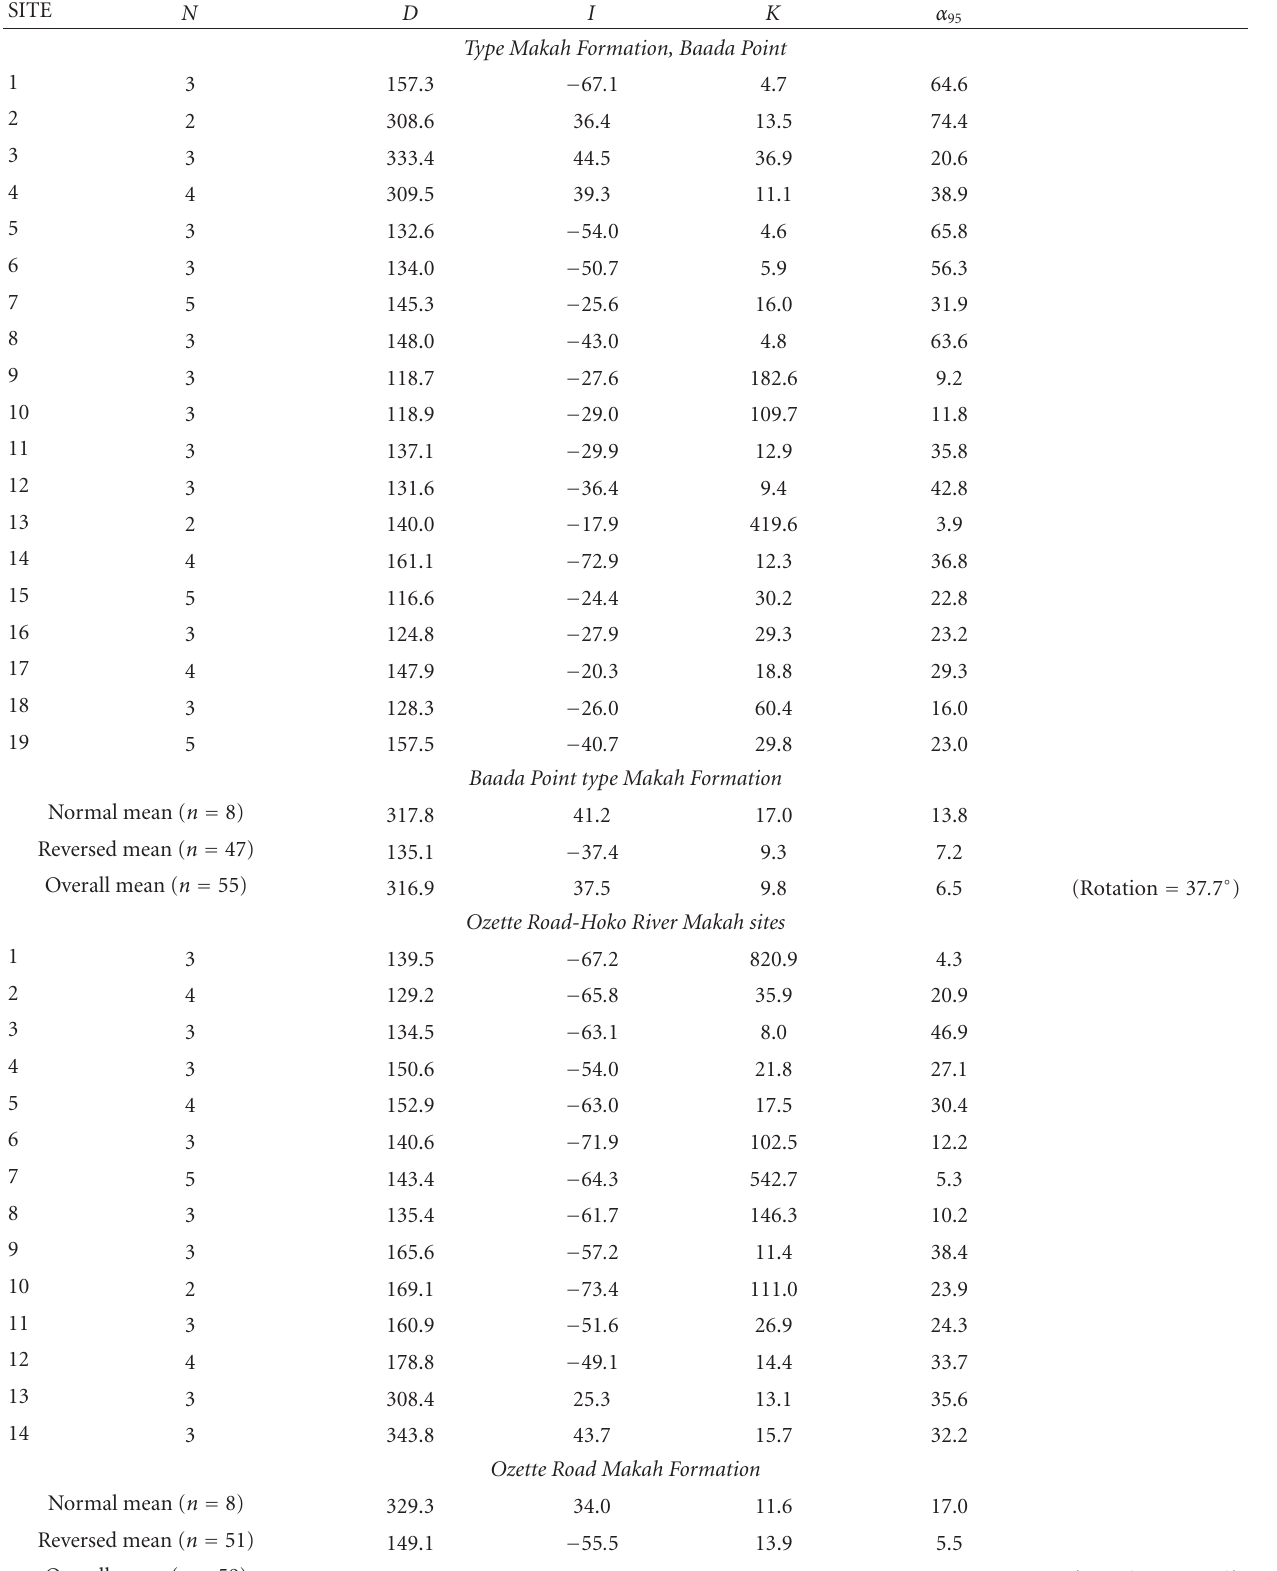
Table 1: Paleomagnetic data and Fisher statistics. N = number of samples per site; D = declination; I = inclination; K = precision parameter; α = radius of circle of 95% confidence around the estimated mean 95